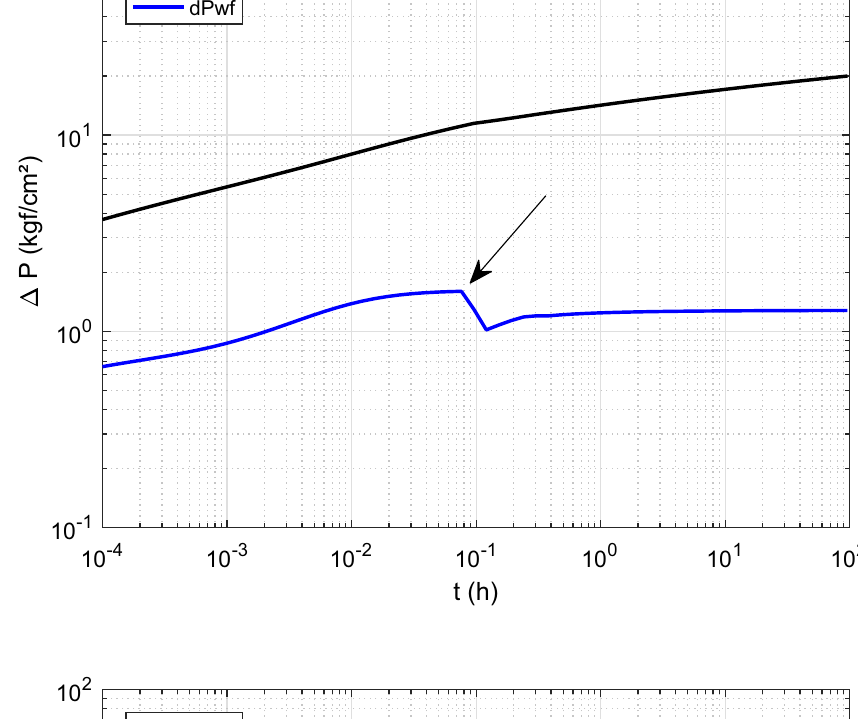
Fig. 2 Pressure and